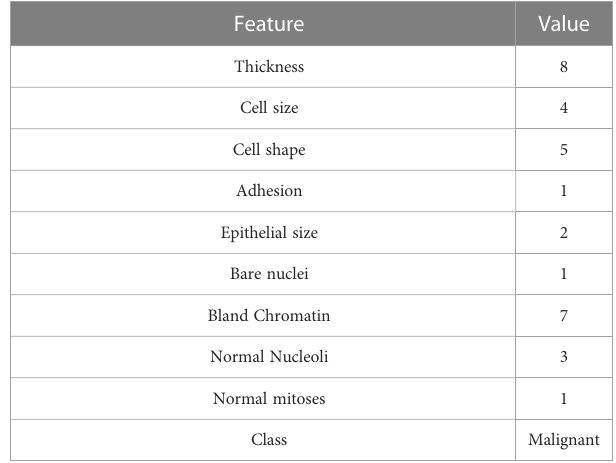
TABLE 4 Feature of the mass sample